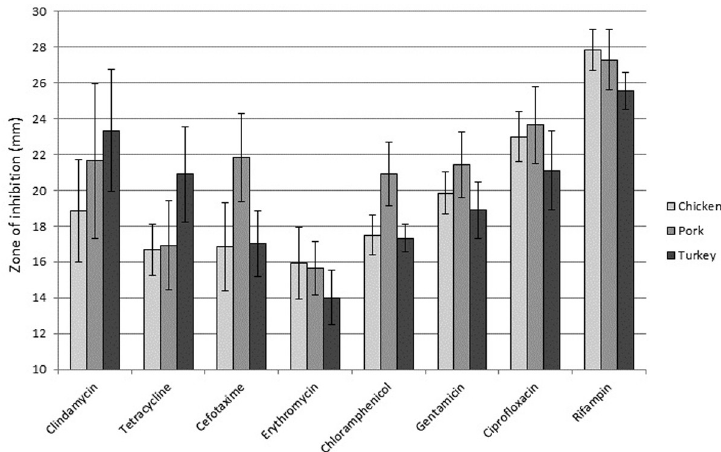
Fig 1. Mean antibiotic resistance in conventional raw meat SA isolates for eight common antibiotics. Disk diffusion tests were performed to determine the amount of antibiotic required to prevent growth of the various SA raw meat isolates. There was only a single SA isolate from beef, and thus no results are reported here for that meat type. Means were calculated and standard error is indicated. Antibiotic concentrations used and significance of zone diameters are detailed in Methods. A two sample t-test with unequal variance test was used to determine if there were significant differences in rates of antibiotic resistance or susceptibility amongst the various meat